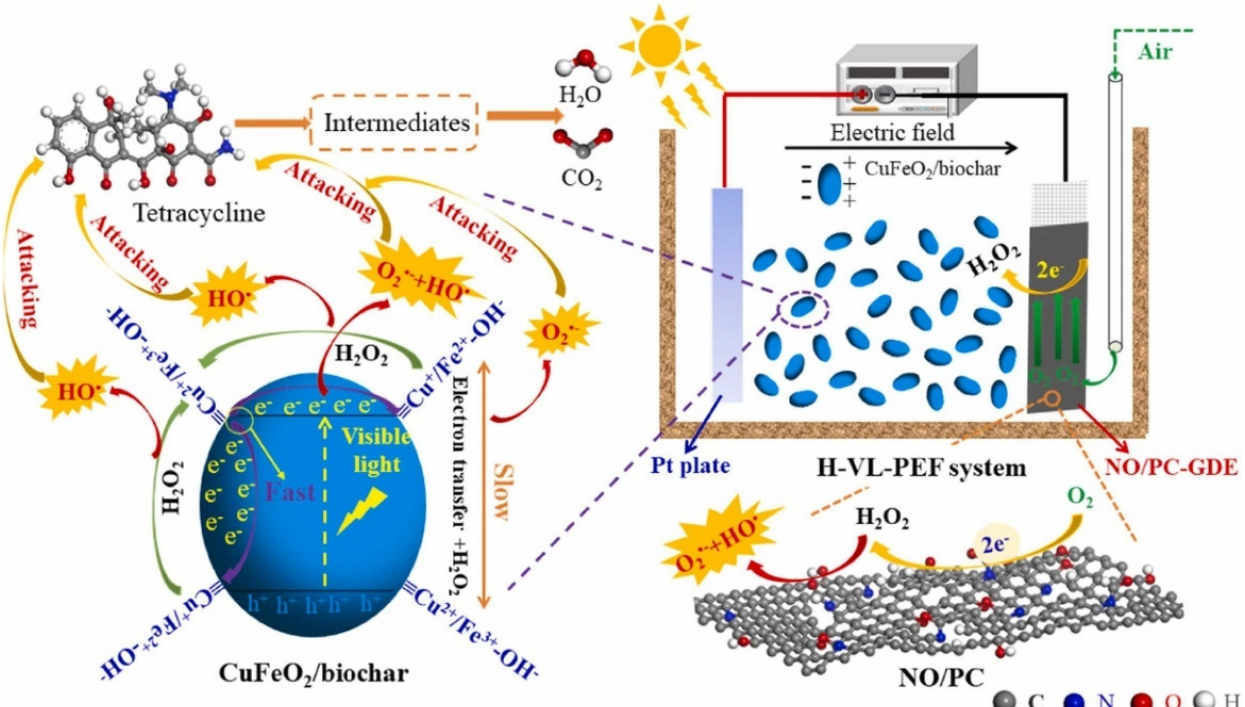
Figure 6. Possible mechanism of tetracycline degradation in the H–VL–PEF system. Reprinted with permission from Ref. [91]. Copyright 2020, Elsevier.